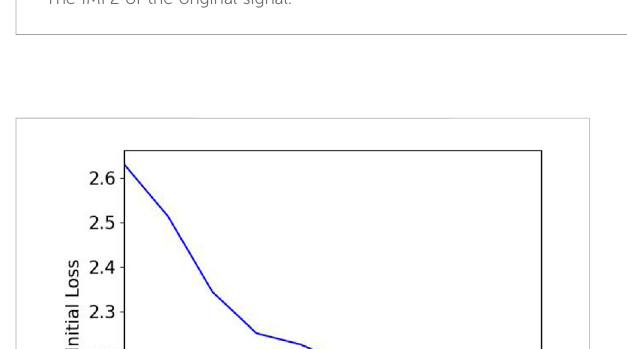
FIGURE 7 The IMF2 of the original signal.